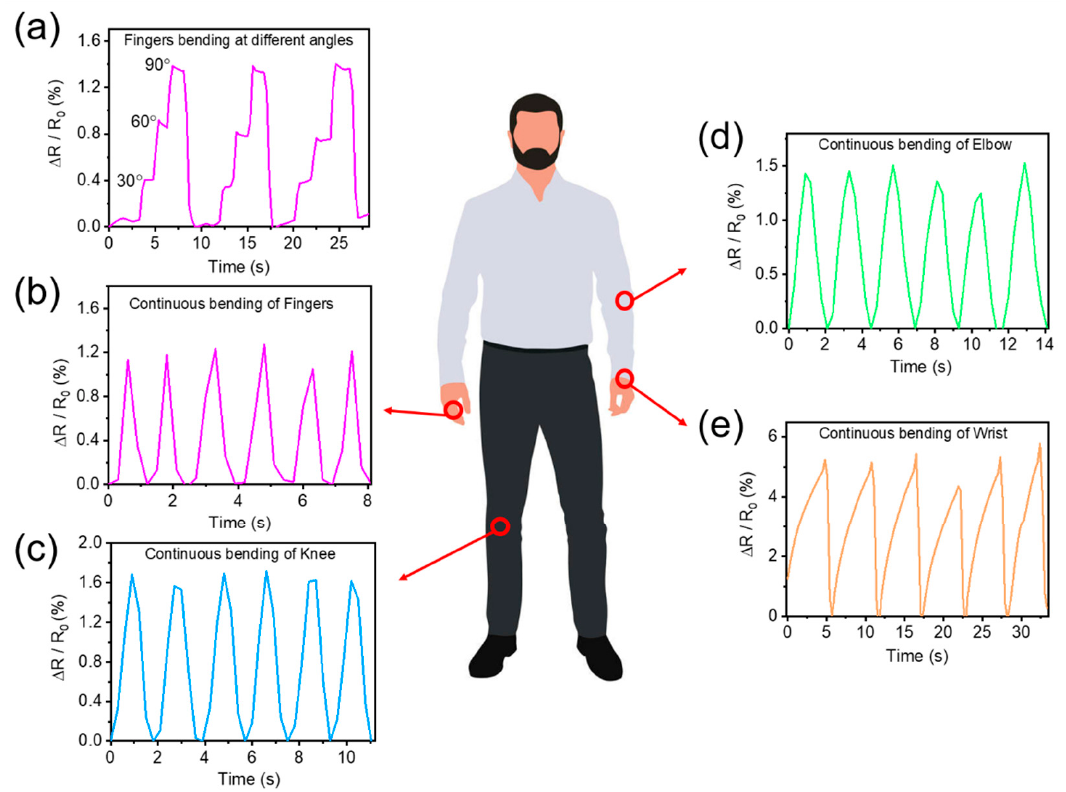
Figure 5. Body movement monitoring applications with the as-prepared CMCS-Ca 2+ /PAAm/PNMA hydrogels by attaching it to different parts of a human body. ( a ) and ( b ) fingers; ( c ) knees; ( d ) elbows; and ( e ) wrists.